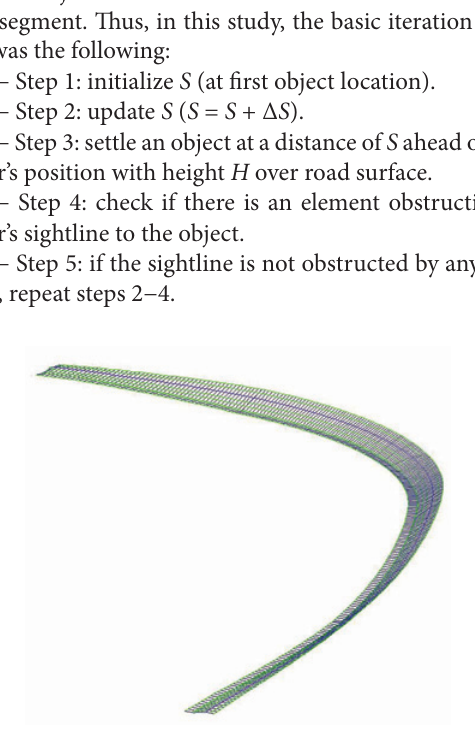
Fig. 1. Representation of the road in the